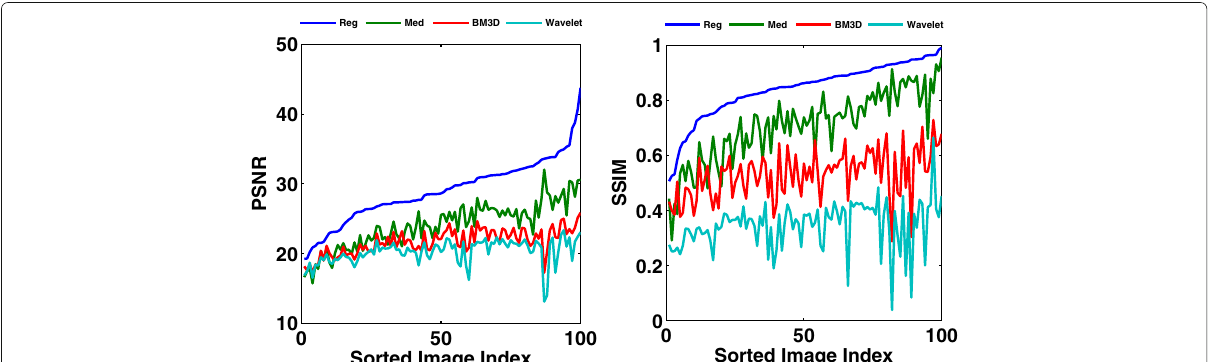
Fig. 13 One-hundred sample images denoised using our regression filter, median, BM3D, and wavelet filters with salt & pepper noise with 20% of corrupted pixels, i.e., p = 0.2